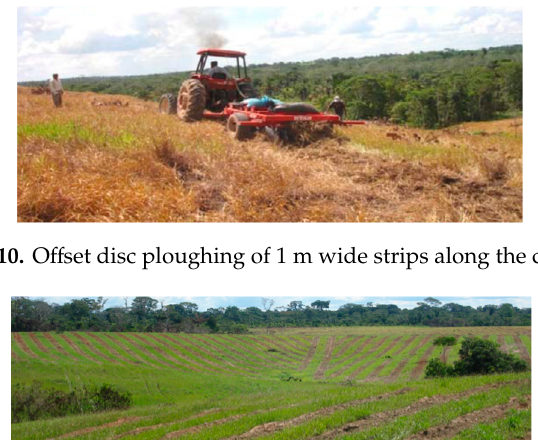
Figure 13. Application of entomopathogens in the planted timber species. Forest protection. Protection measures include the application of environmental strategies for the prevention and control of pests and diseases, the compliance with legal and technical regulations on industrial safety and hygiene, and the involvement of the neighbouring population through good coexistence relations (Figure 14).